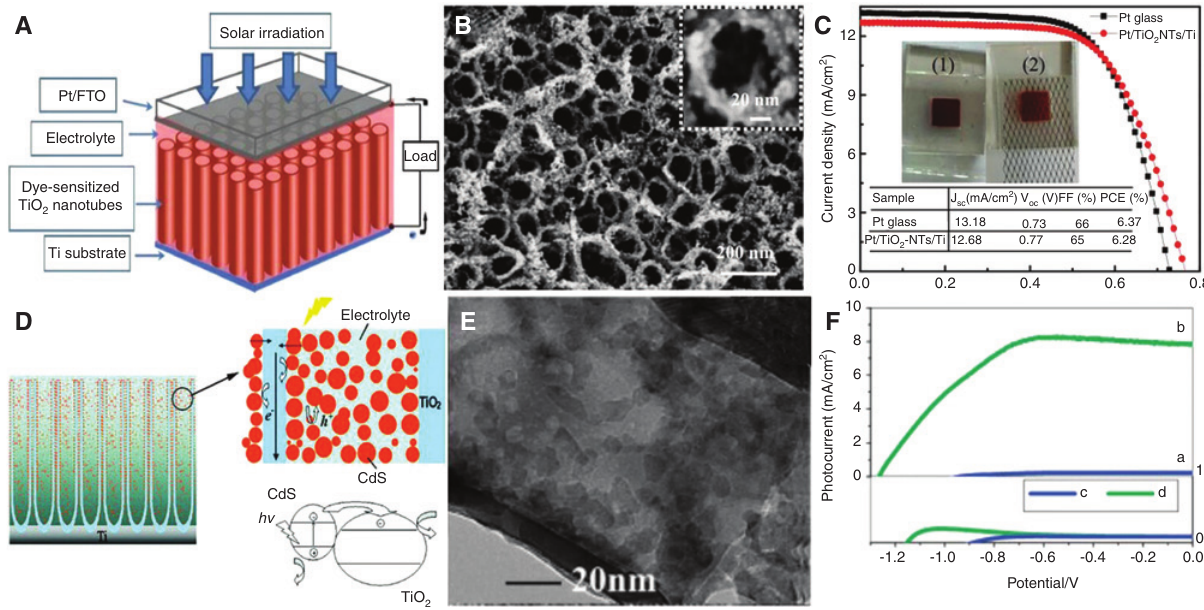
NTAs on Ti substrate (A). SEM image of Pt/TiO NTAs (B). J-V curves of DSSCs with Figure 25: Backside illuminated DSSC based on TiO 2 2 Pt/FTO and Pt/TiO NTAs/Ti mesh as counter electrode (C). Sketch showing the nanostructure of CdS modified TiO nanotube film elec- 2 2 trode and charge-transfer processes between CdS and TiO (D). SEM image of CdS/TiO NTAs (E). Photocurrent versus voltage spectra 2 2 (F) in 1-M Na S solution under solar light illumination for plain (a) and CdS quantum dot-modified TiO nanotube film electrode (b). (c, d) 2 2 Corresponding currents in the dark for curves a and b. Reproduced from Ref. [30] with permission. Copyright Hindawi Publishing Corpora- tion. Reproduced from Ref. [252] with permission. Copyright Elsevier. Reproduced from Ref. [265] with permission. Copyright American Ceramic